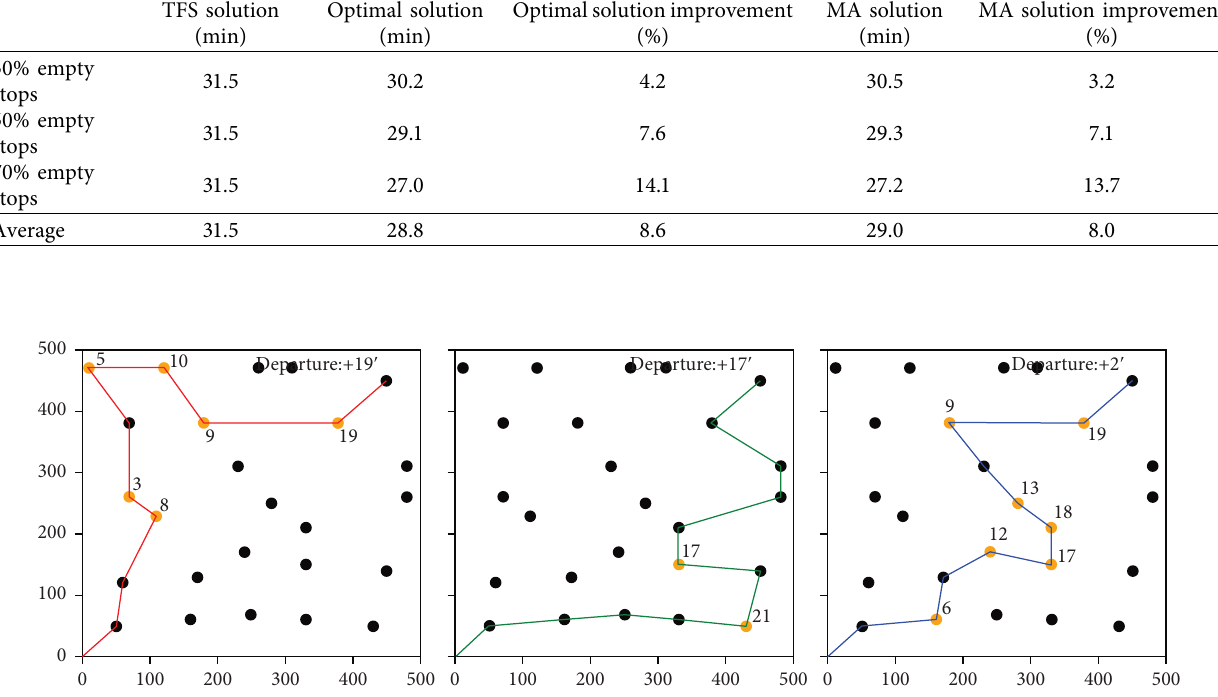
Figure 9: Example of MA solution for the third operation period with 50% of empty stops. Table 7: Results of average passenger waiting, in-vehicle, and total travel times for the TFS and the MA grouped by percentage of empty stops in the